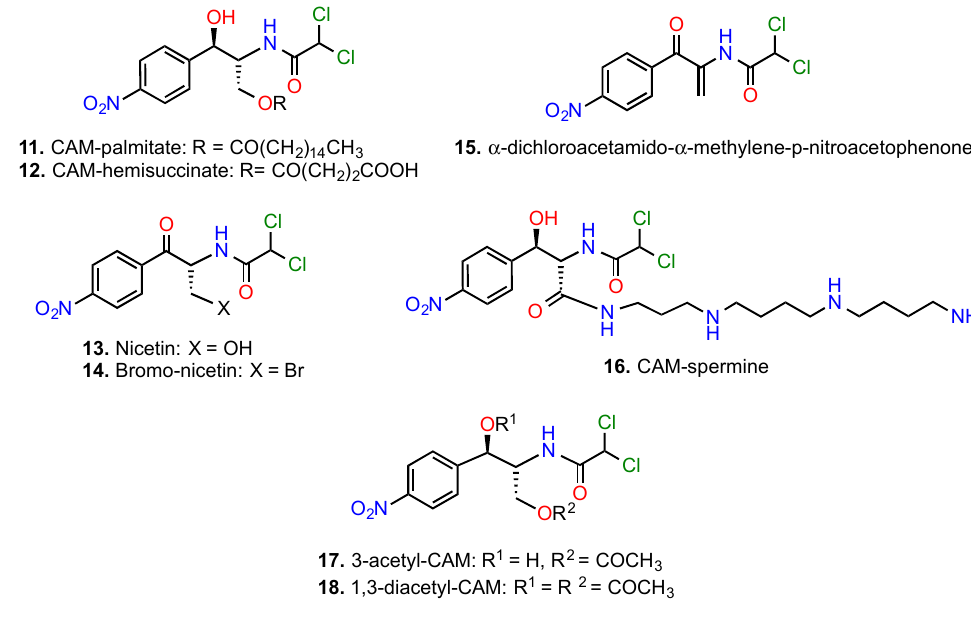
Figure 6. Derivatives of CAM modified at the 2-amino-1,3-propanediol moiety.